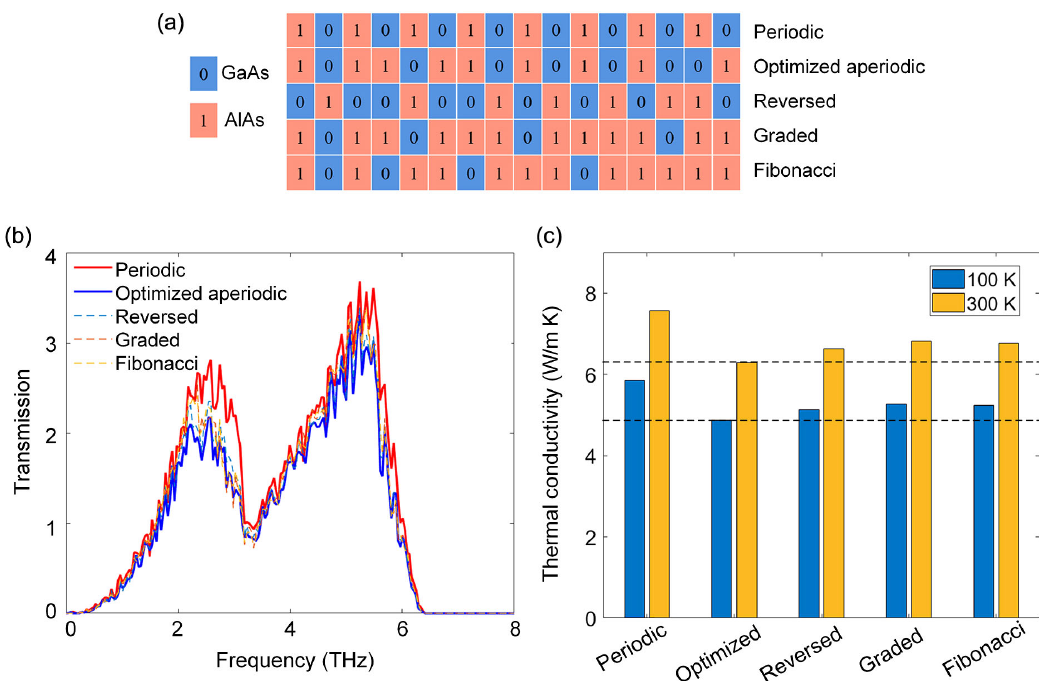
FIG. 7. Comparison of the current optimized structures and other representative aperiodic structures: reversed, graded, and Fibonacci structures. (a) Schematic of the SL configuration for the different structures. (b) Phonon transmission spectra and (c) thermal conductance of the periodic, optimized, reversed, graded, and the Fibonacci structures. Black dashed lines in (c) are the guide to